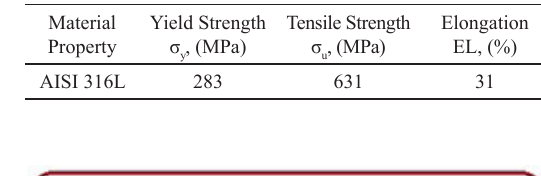
Table 2. Mechanical properties AISI 316L.